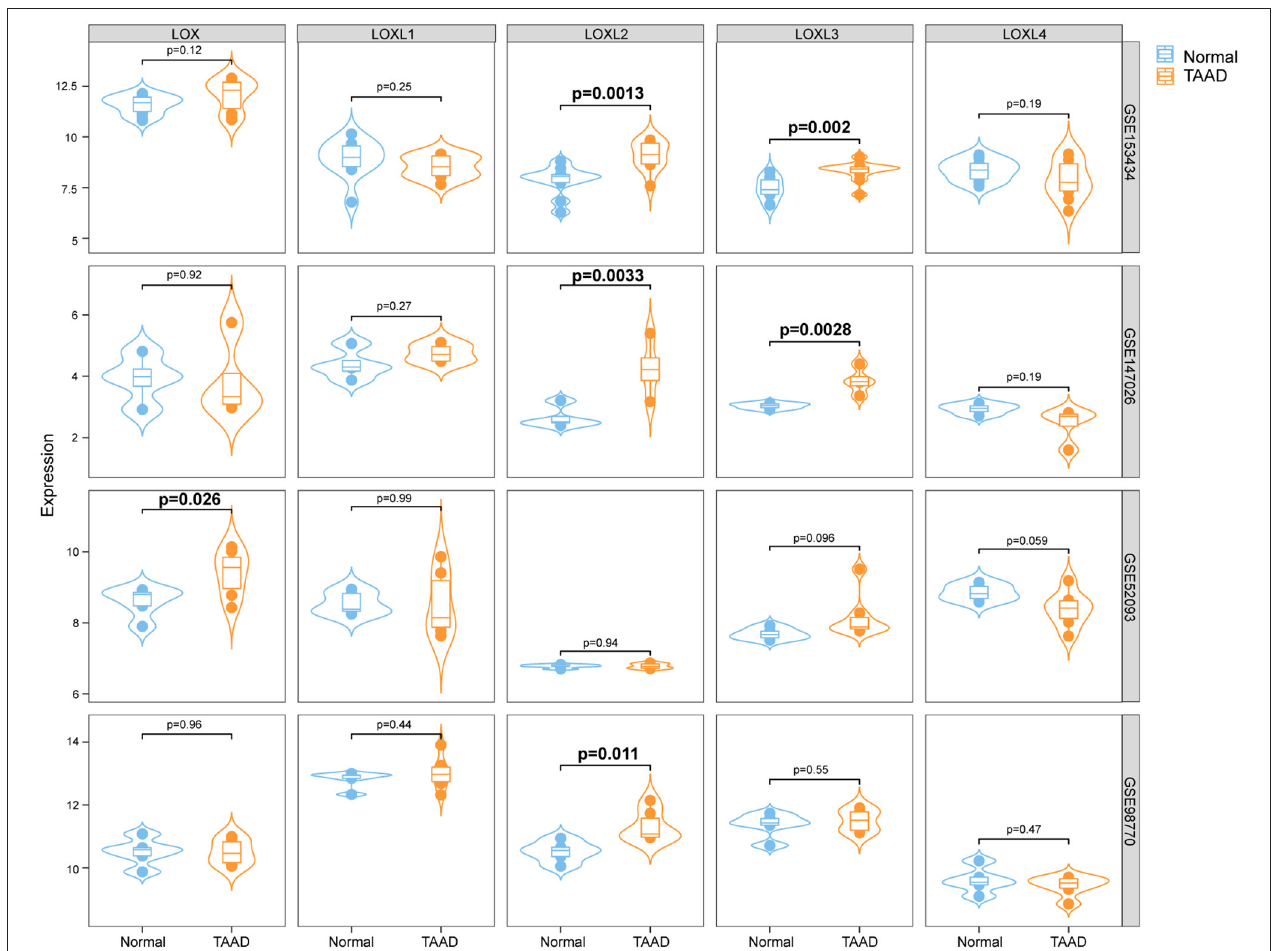
FIGURE 1 | The relative mRNA levels of LOXs in the aortas of individuals with or without AD. We downloaded four datasets from the GEO database, and the relative mRNA levels of LOXs in the GSE153434, GSE147026, GSE52093, and GSE98770 datasets are shown. Normal indicates aorta samples from individuals without aortic dissection, and TAAD indicates aorta samples from individuals with Stanford type A aortic dissection.